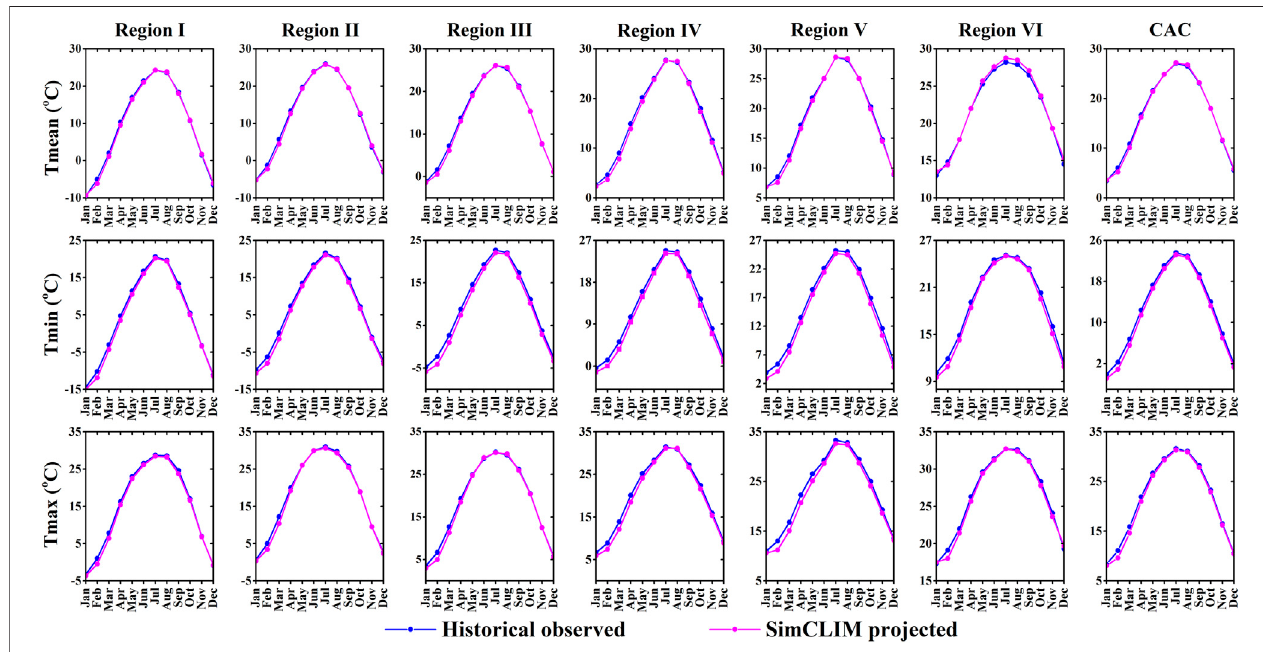
FIGURE 2 | Annual cycle of monthly average Tmean, Tmin, and Tmax evaluation between the observations and projections over CAC during 1996 – 2018.